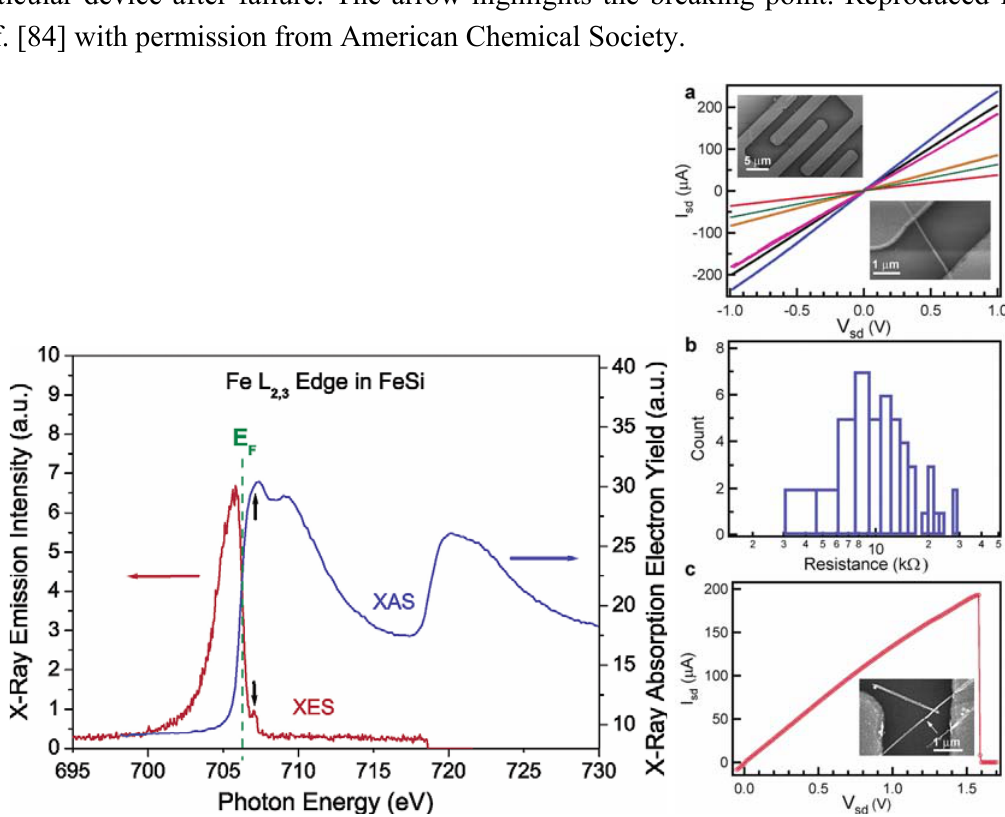
edge. The black 2,3 vs V for sd sd vs V recorded for a typical sd g